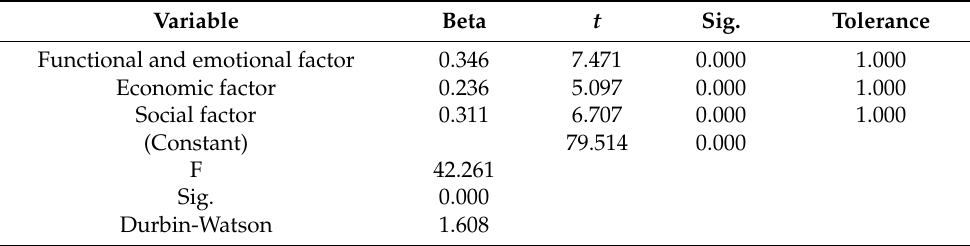
Table 3. Relationship of perceived value and intentions to